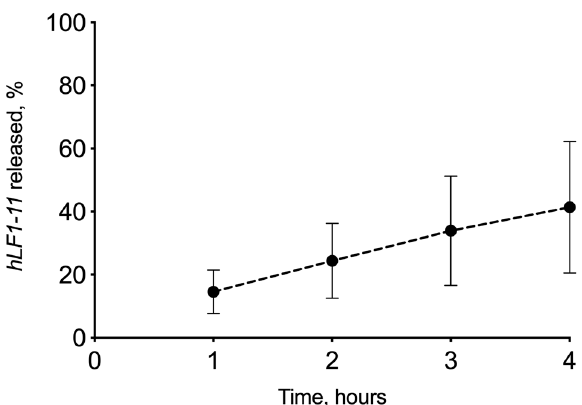
Figure 6. In vitro release profile of hLF 1-11 in phosphate buffer saline (PBS) from the freeze-dried matrix HPMC / T2 / HA / hLF 1-11 containing a hydroxypropilcellulose (22.43 wt %) hyaluronic acid (2.49 wt %), trehalose (49.8 wt %), mannitol (24.92 wt %), and hLF 1-11 (0.33 wt %). Data represent mean ± standard error ( n = 3).